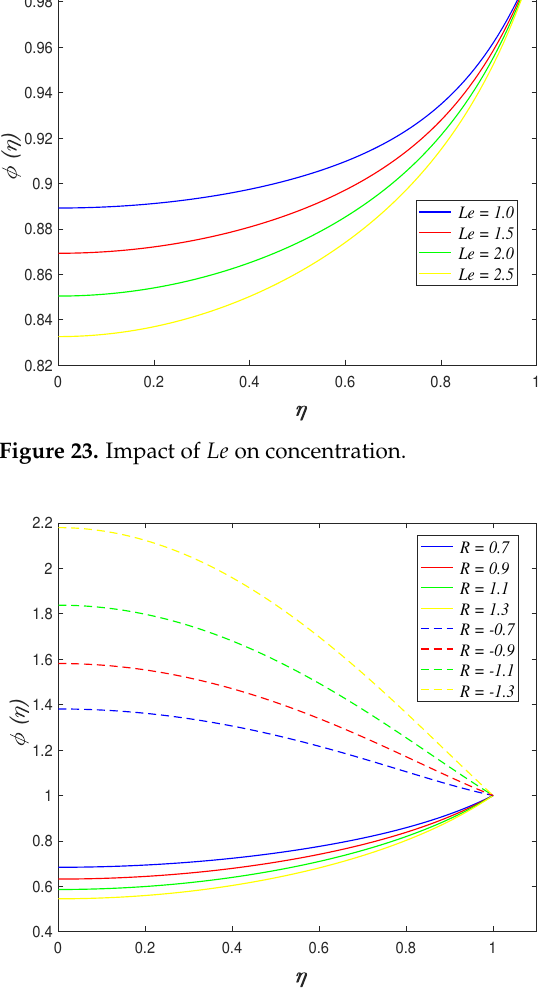
Figure 24. Impact of R on